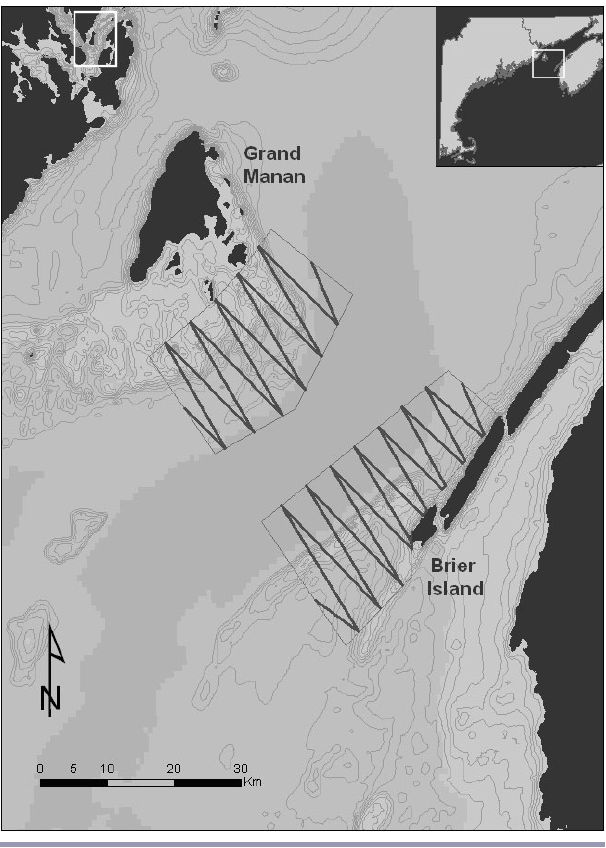
Fig. 1 . Location of study area in the outer Bay of Fundy, Canada between New Brunswick and the southwestern tip of Nova Scotia. Marine depth contours, range -5 to -100 m, are shown. Aerial line transects (n = 28) were allocated over two nonoverlapping survey regions, “Brier” and “Grand Manan.” Strong tidal currents collide with ledges and shoals to generate enhanced vertical mixing in both regions. Note: location of Head Harbour Passage where large flocks of P. lobatus staged until the mid-1980s shown in upper left